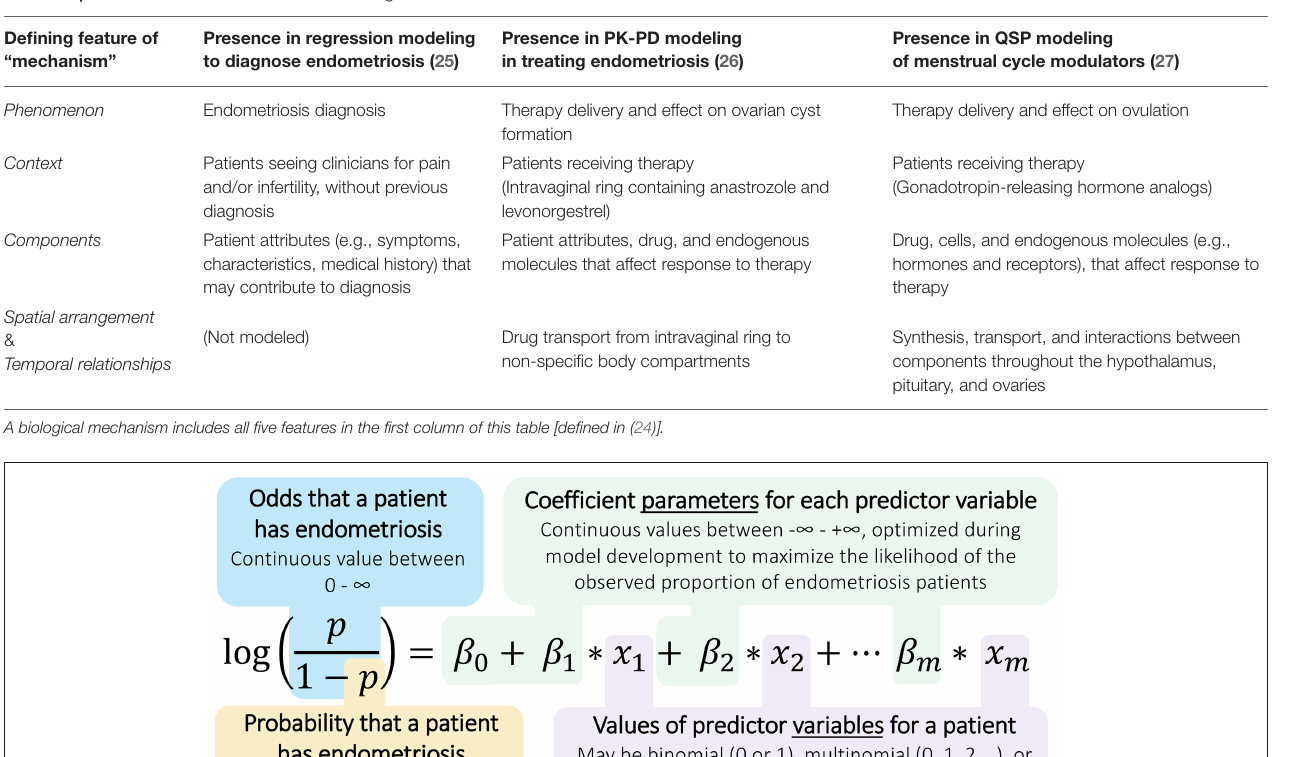
TABLE 1 | Overview of mechanism-based modeling and discussion in this review.